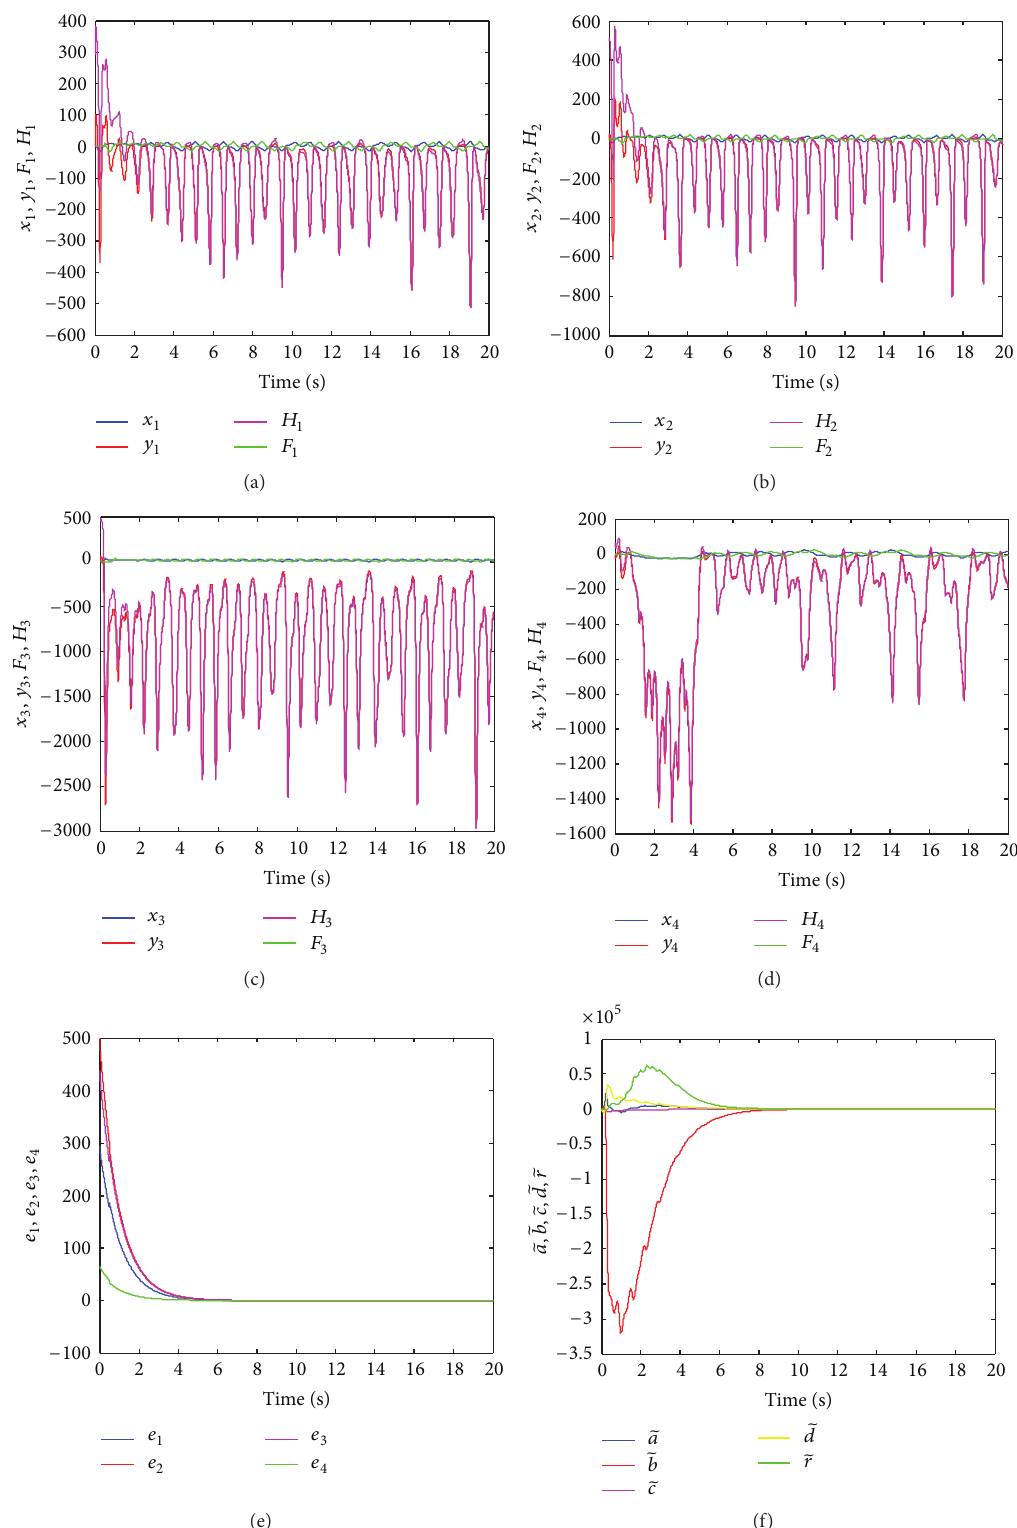
Figure 3: Time histories of states, state errors, parameter differences, 𝐹 1 , 𝐹 2 , 𝐹 3 , 𝐹 4 , 𝐻 1 , 𝐻 2 , 𝐻 3 , and 𝐻 4 for Case